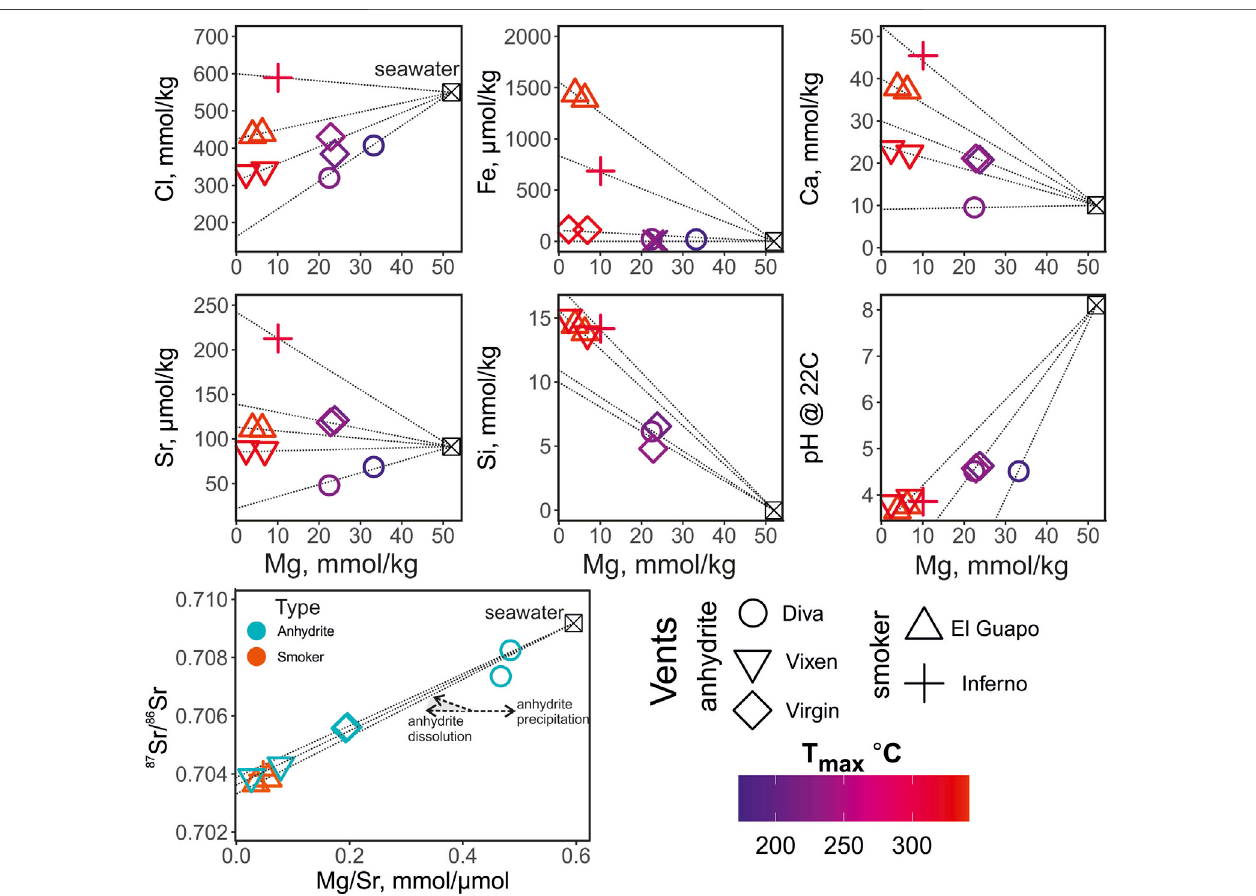
FIGURE 2 | Elemental composition and pH of the vent fl uids from the Axial Seamount color-coded by the maximum temperature measured at the vent (T max , ° C). The thin dotted black lines show interpolation of the elemental concentration values from seawater (Mg (cid:1) 52 mmol/ kg) to the hydrothermal fl uid endmember compositions (0 mmol/ kg). The 87 Sr/ 86 Sr values are plotted against the Mg/Sr ratios to trace the zero-Mg endmember values and to distinguish anhydrite precipitation and dissolution.Theanhydritedissolutionisshownwithtwoarrowsandthegrey fi eldindicatingseveralpossibletrajectoriesduetothepossibledifferencesin 87 Sr/ 86 Sr of anhdrite. The symbols in the Mg/Sr — 87 Sr/ 86 Sr plot are color coded by the type of the vent site (anhydrite- and smoker-types).